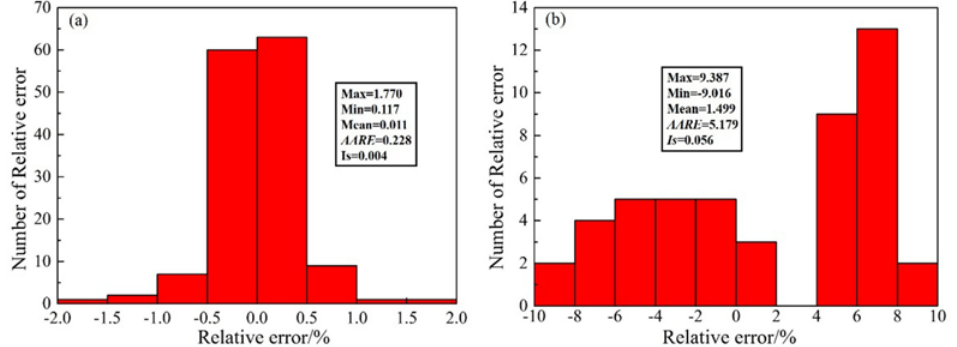
Figure 9. Distribution of relative errors between the developed ANN model and experimental results: ( a ) training sets and ( b ) testing sets.